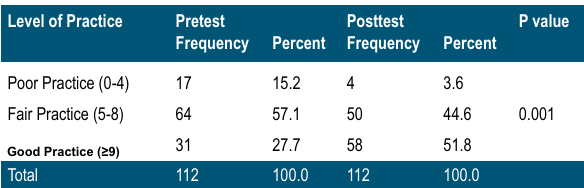
Table 4: Impact of Menstrual Educational Programme on Level of Practice Regarding Menstrual Hygiene